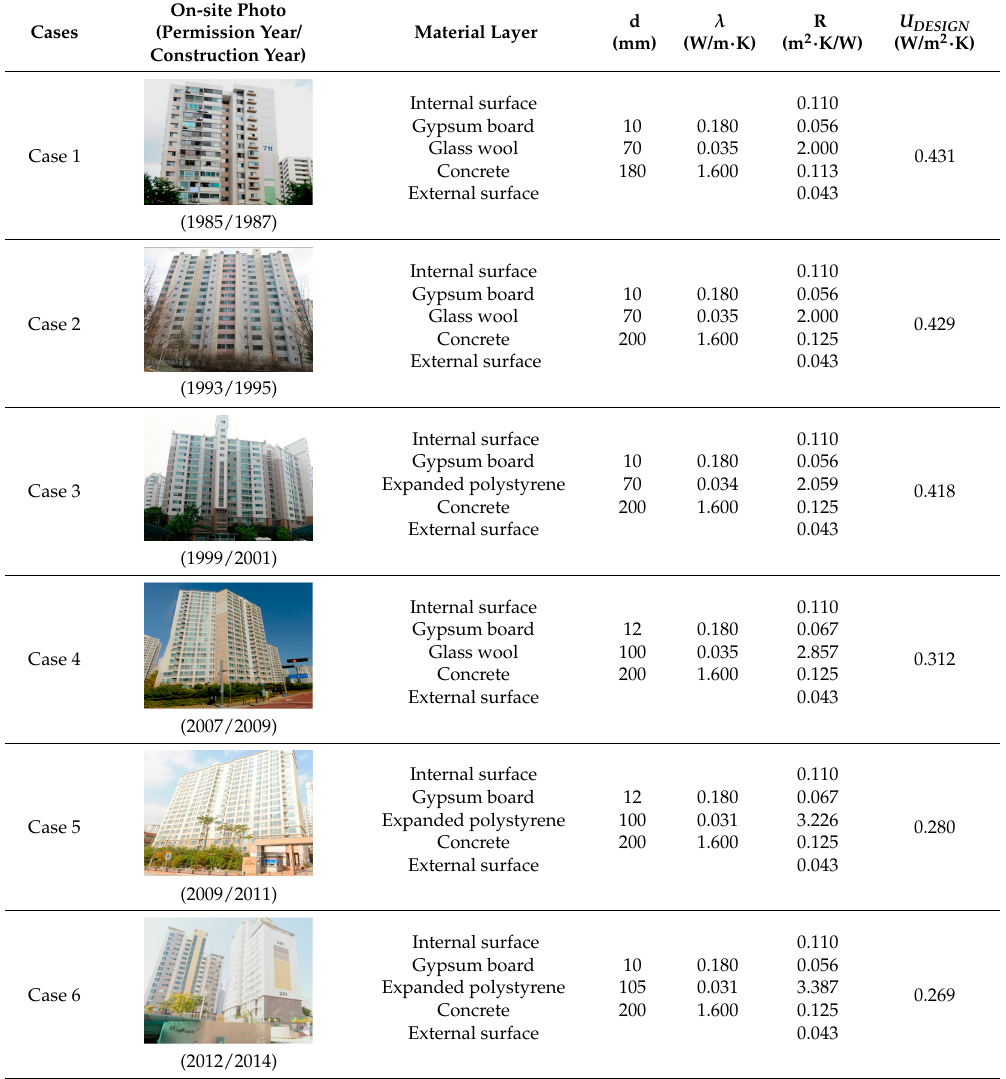
Table 1. Stratigraphies and thermophysical properties of the six cases examined, and the thermal transmittance values obtained by calculation